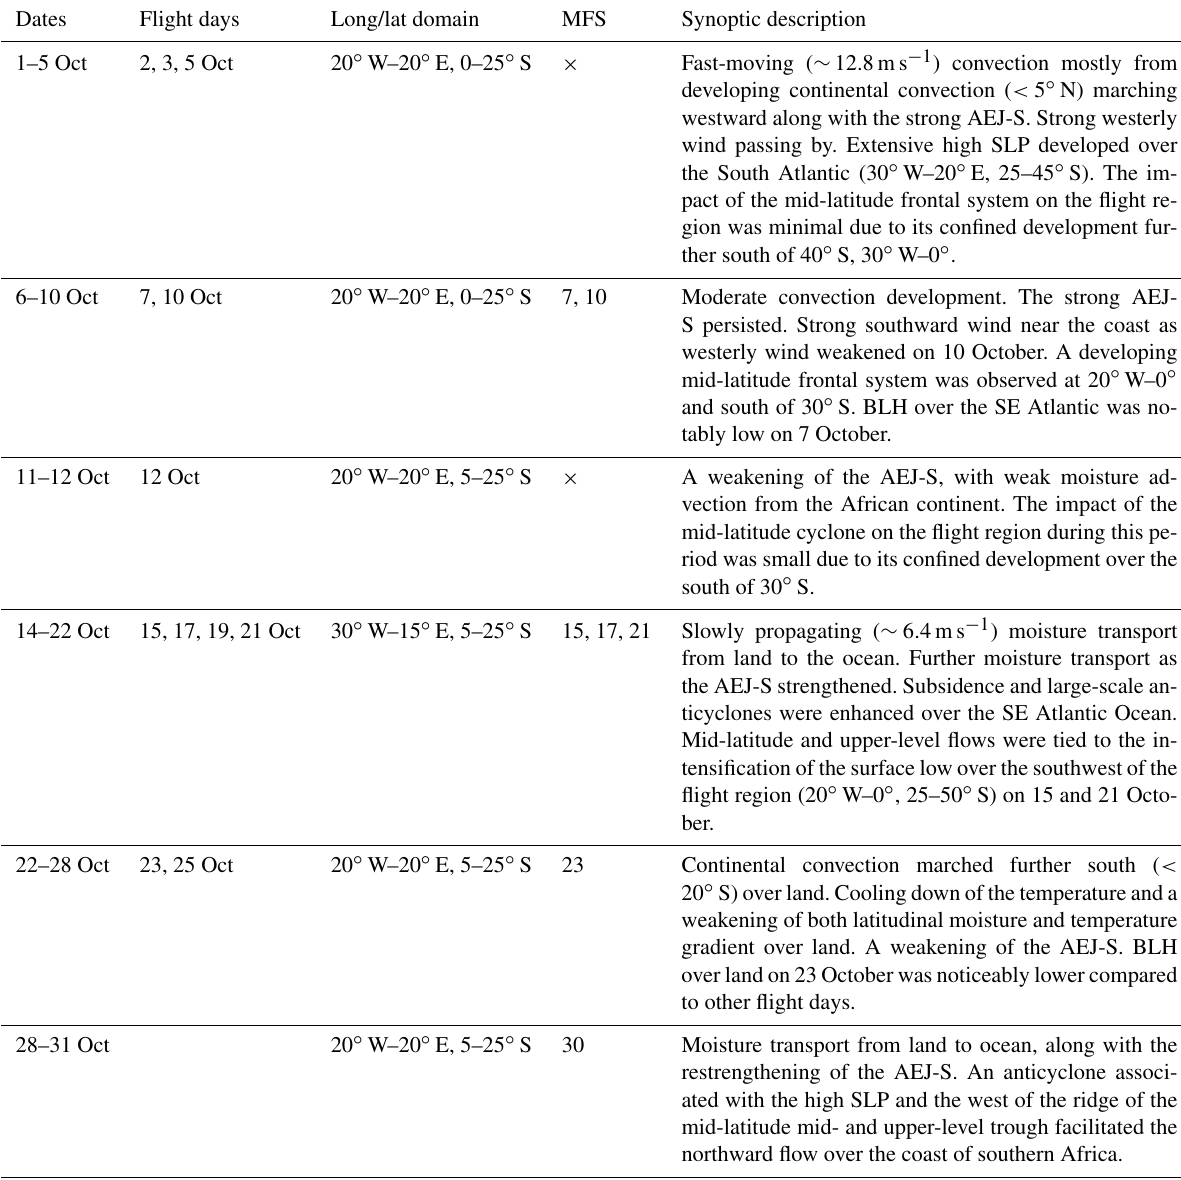
Table 3. Characteristics of synoptic-scale features over SE Atlantic during the October 2018 deployment. The P-3 flights were available in October 2018. MFS represents the mid-latitude frontal system affecting the flight region on that day ( × sign represents no